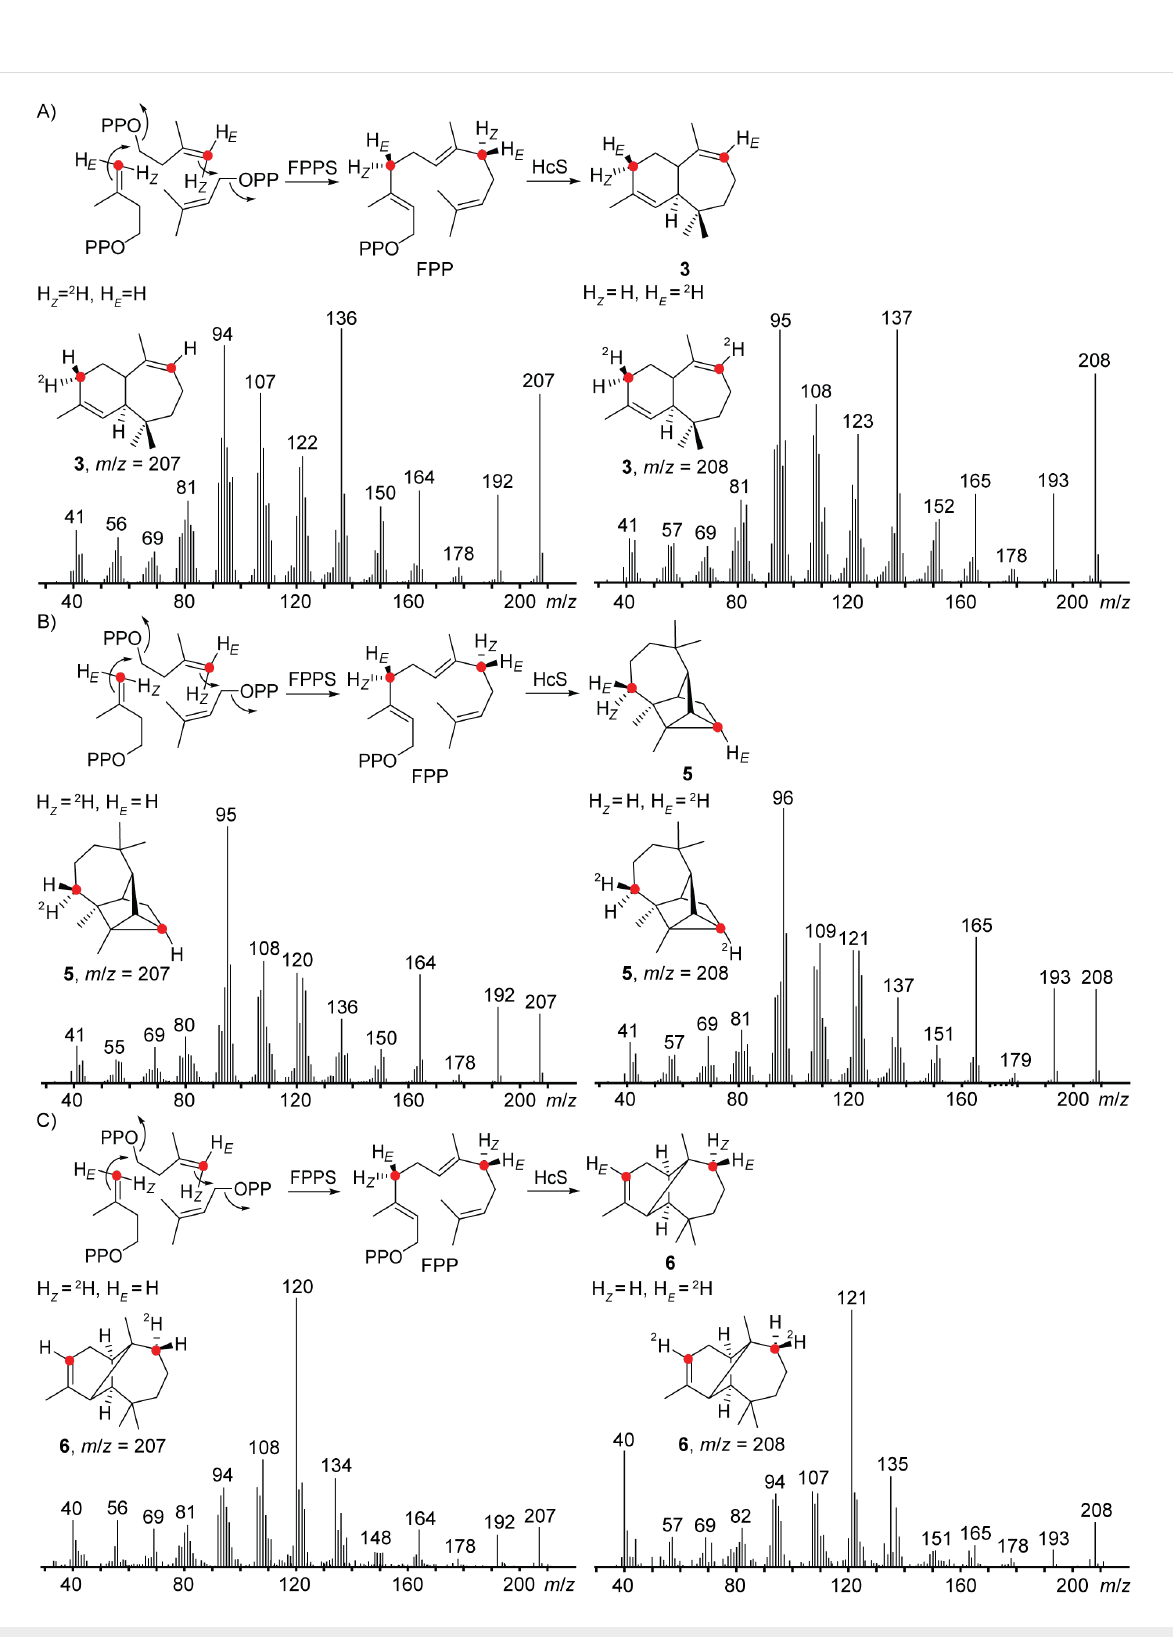
Figure 4: Stereochemical course of the final deprotonation step towards 3 , 5 and 6 investigated by GC–MS. EI mass spectra of labelled A) 3 , B) 5 and C) 6 obtained from the incubation of HcS and FPPS with DMAPP and ( Z )-(4- 13 C,4- 2 H)IPP (left) or ( E )-(4- 13 C,4- 2 H)IPP (right) indicating stereo- specific loss of one hydrogen atom. 13 C-Labellings are indicated by red